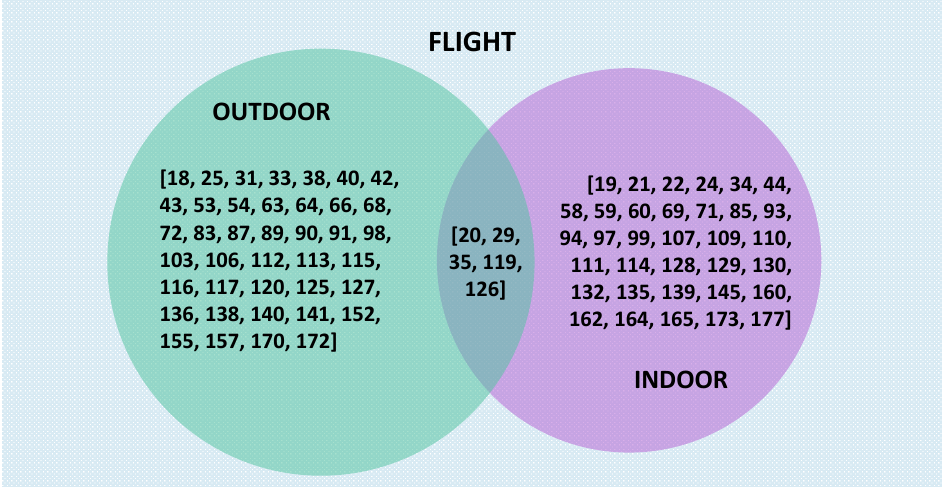
Figure 19. Papers per flight